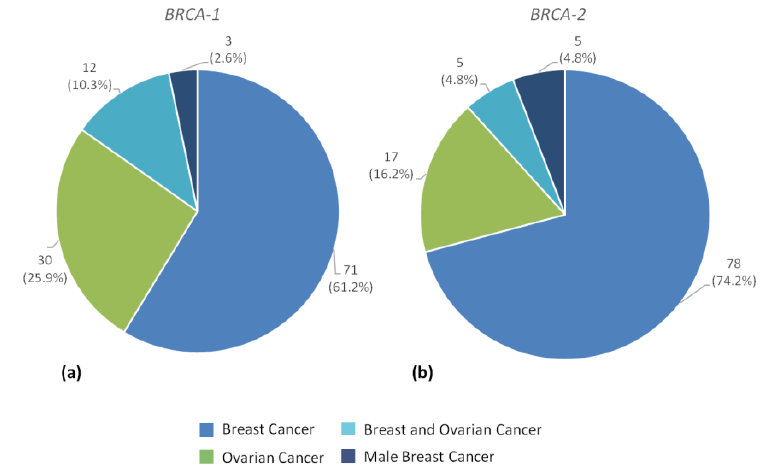
Figure 2. Type of tumors in all individuals carrier of germline BRCA1 ( a ) or BRCA2 ( b ) PVs (probands and family members). Table 2. Total number of tested individuals (probands and family members), number of individuals carrier of germline BRCA1/2 PVs and type of tumors.